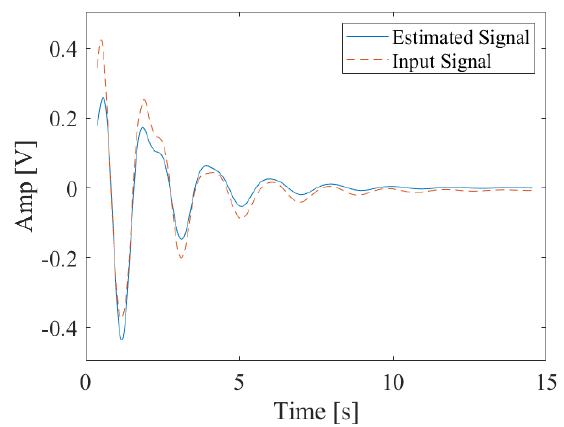
Figure 17. Test signal obtained by Kundur’s Simulink R (cid:13) model and its estimation according to the proposed approach.